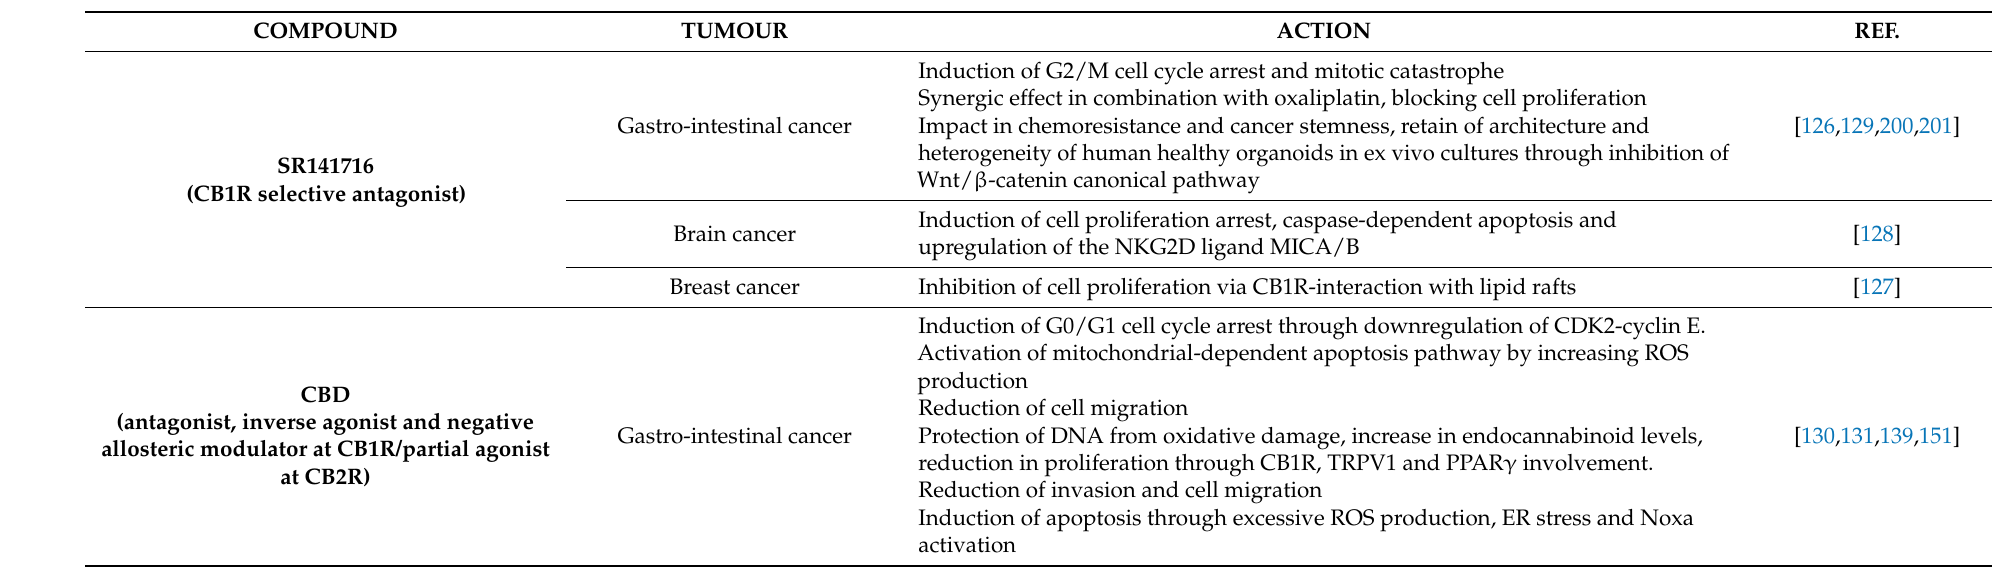
Table 3. In vitro evidence of the main cannabinoid receptor antagonist/inverse agonists in different tumour